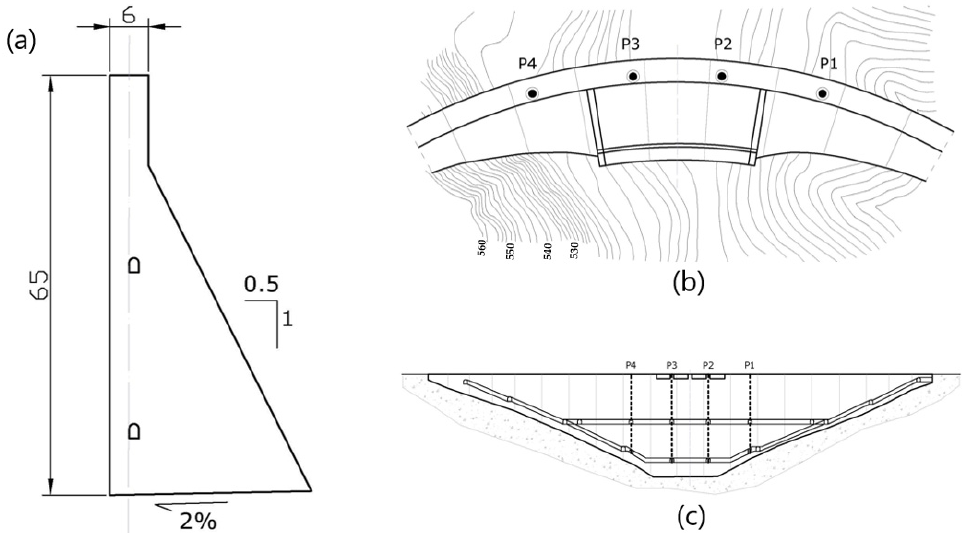
Figure 6. Cross-section ( a ), Plan ( b ) and section ( c ) of the dam. The source of this figure relies on